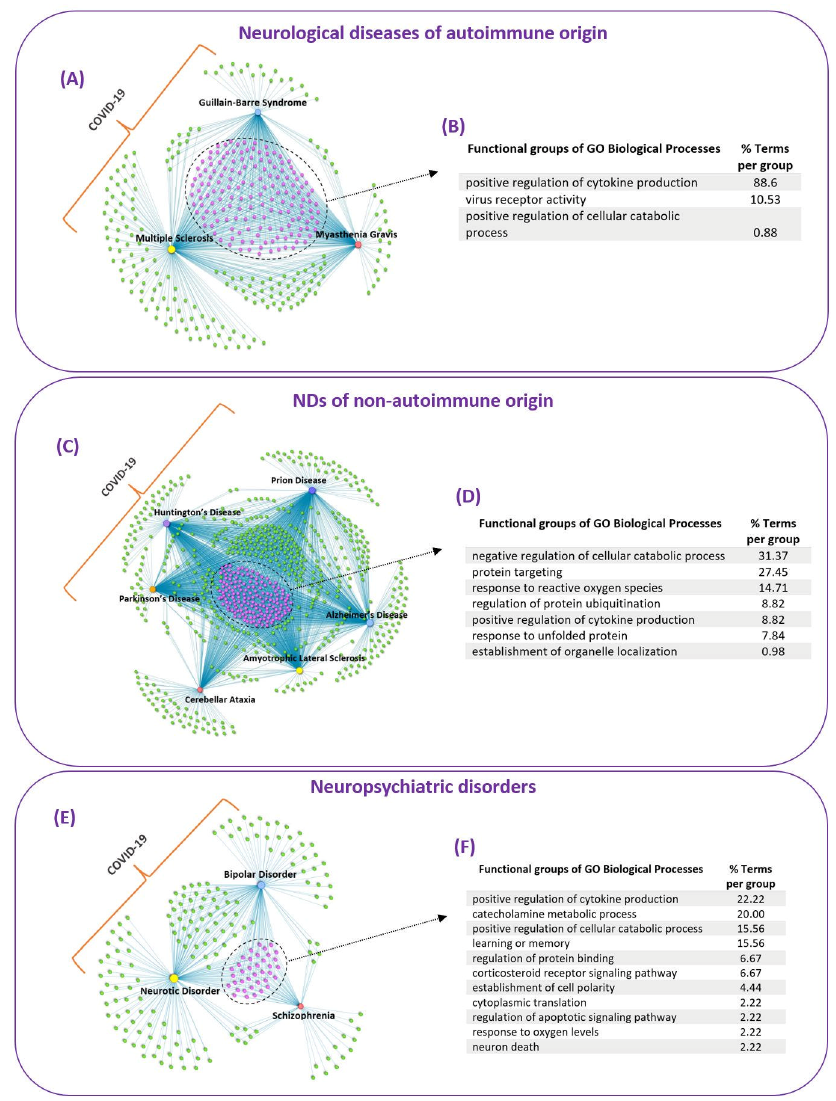
Figure 4. Integrated Networks of Common GO Biological Processes Affected by COVID-19 in Groups of Diseases/Disorders . The common GO biological processes are indicated in purple color in the three integrated networks of groups of diseases/disorders, which are classified based on their main pathological characteristics: (i) neurological diseases of autoimmune origin, (ii) NDs of non-autoimmune origin and (iii) neuropsychiatric disorders ( A , C , E ). Functional groups that the common GO biological processes of each group/network belong to ( B , D , F